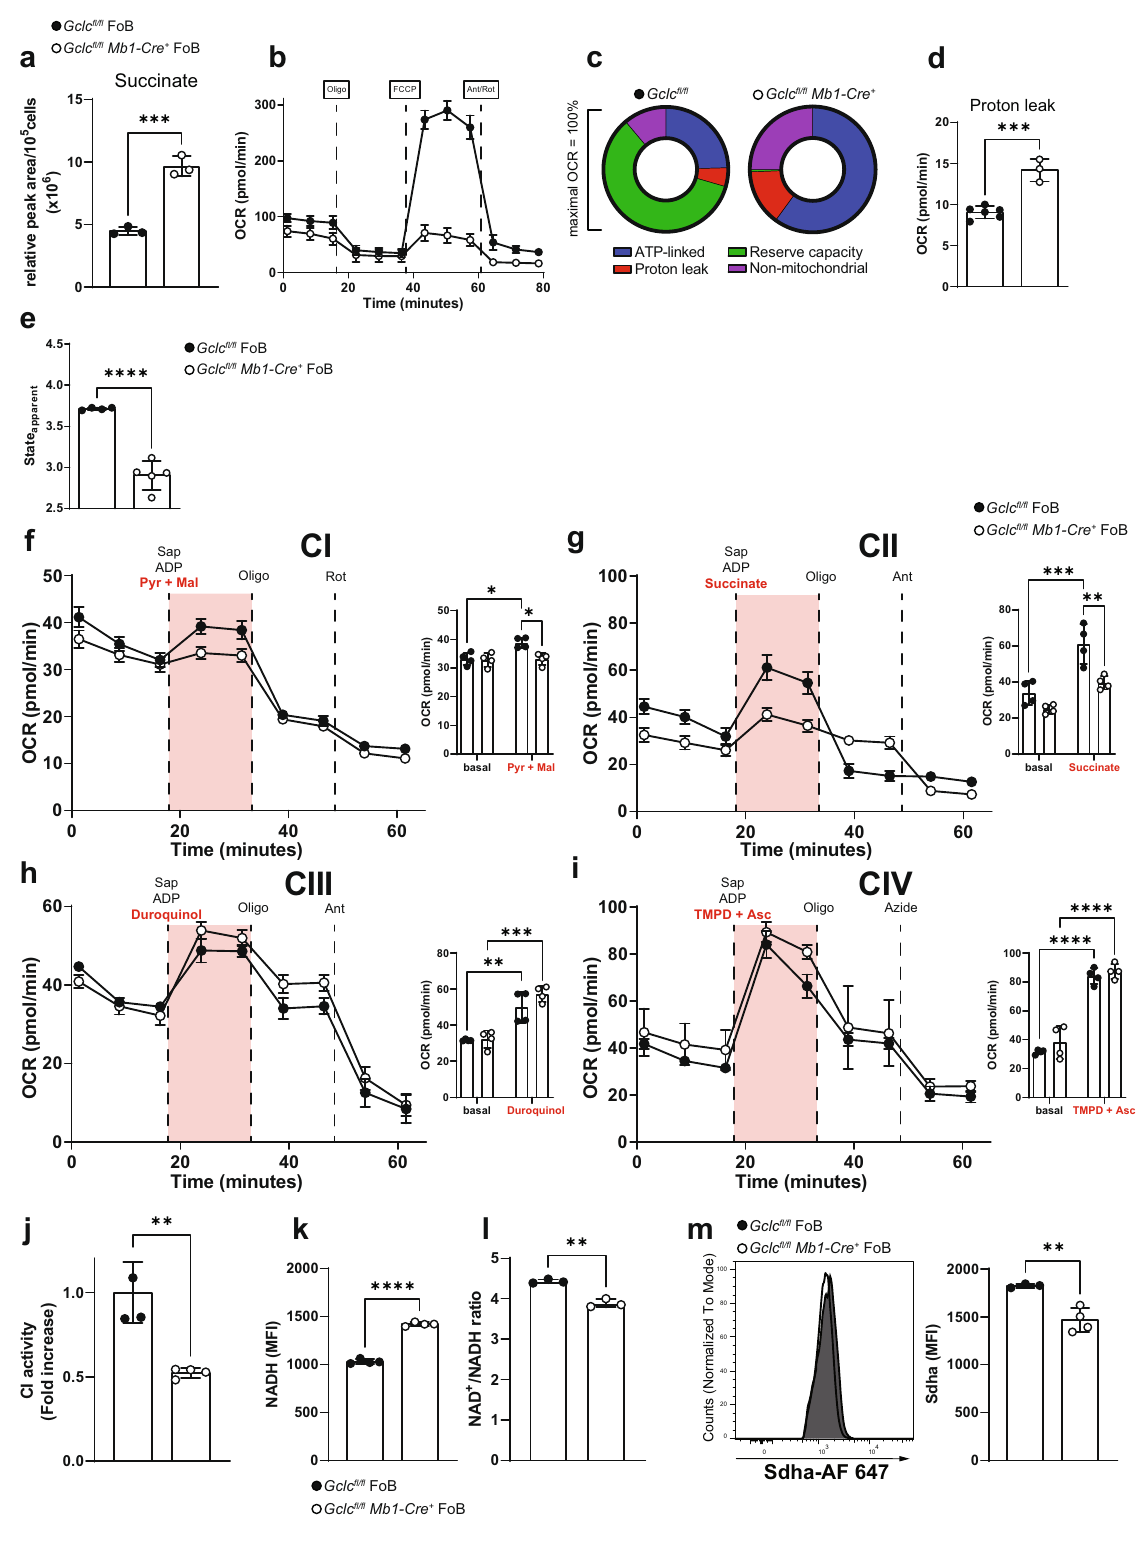
Discussion ROS-induced signals regulate B cell activation and early metabolic reprogramming 97,98 , and a fl exible redox system controls B cell differentiation 31,99,100 . Compared to FoB, MZB were previously shown to use GSH through Gpx4 for protection from excessive lipid peroxidation 33 , suggesting a differential dependency on